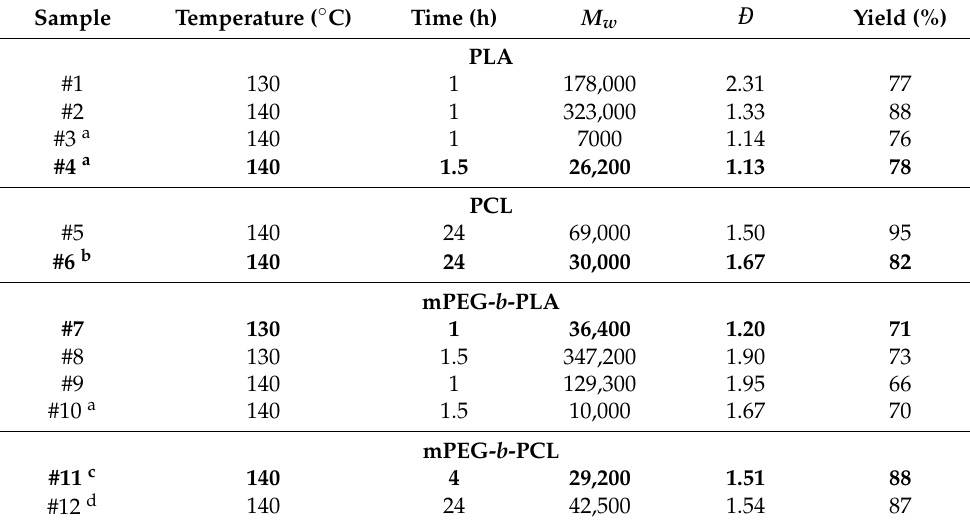
Table 1. Effect of polymerization temperature and time of reaction on the yield and molecular weight of synthesized (co)polymers. Conditions: PLA and mPEG- b -PLA synthesis,